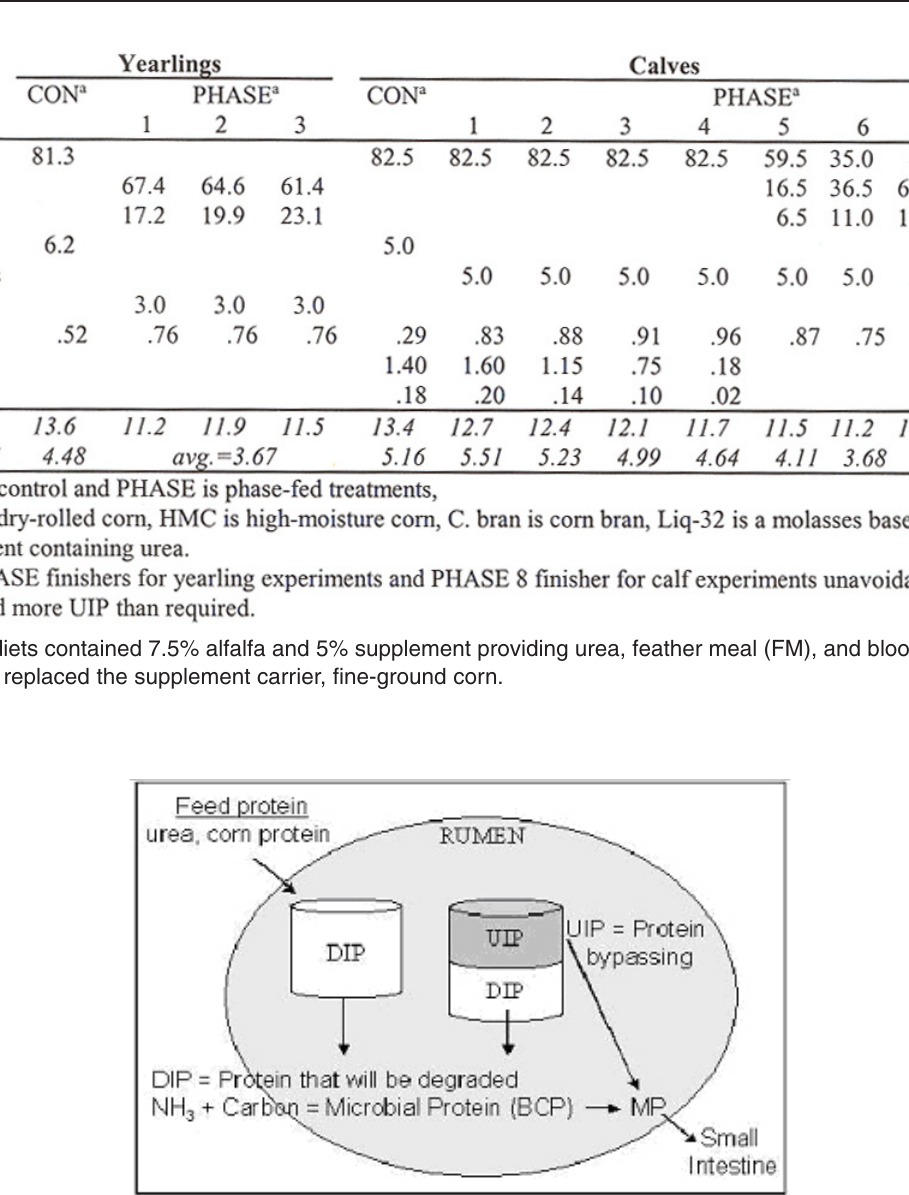
Diet Composition (% of DM) for Yearlings and Calves